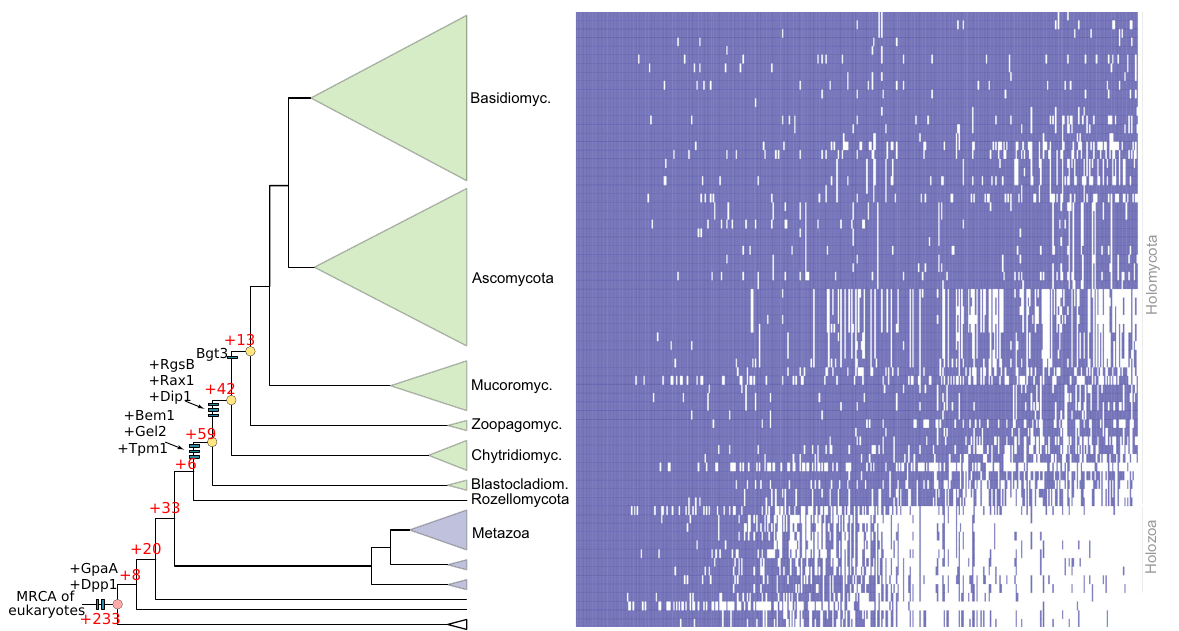
Fig. 5 Origin of 414 gene families potentially related to the evolution of hyphal MC, identi fi ed by ANOVA ( P < 0.05). 114 families originated in BCZ nodes (shown in yellow), including known morphogenesis-related proteins (e.g. Bgt3, RgsB, Gel2 of A. fumigatus , Rax1, Bem1, Tpm1, and Dpp1 from S. cerevisiae , Dip1 from S. pombe ) labeled as blue bars. Red numbers represent the number of gene families originated at the respective branches. Heatmap next to the tree shows the conservation of the identi fi ed 414 gene families across fungi. Blue and white colors indicate that the gene family is present or absent in the genome,